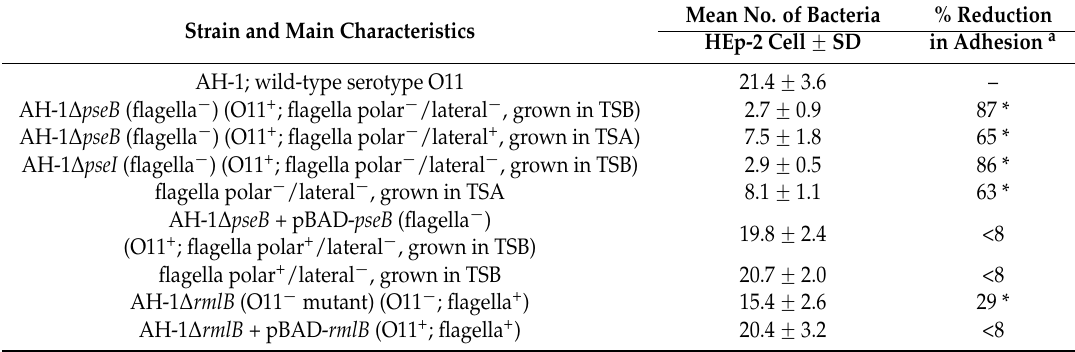
Table 1. Adhesion of different A. hydrophila AH-1 serotype O11 strains to HEp-2 cells as described in Experimental Section. Values presented are mean ˘ SD from three independent experiments carried out in duplicate or triplicate ( n = 6 or n =